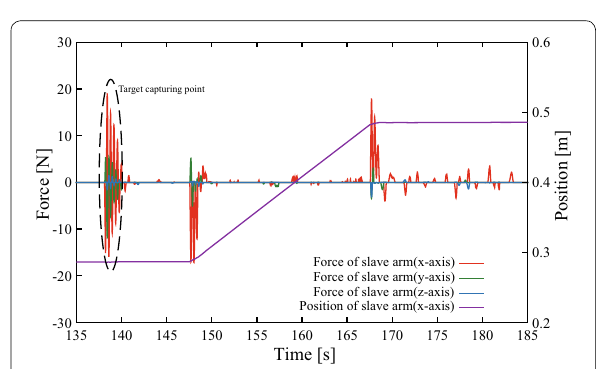
Fig. 11 Force and position of slave arm with force feedback Table 3 Mass and inertia parameters of the payload (4500 kg)